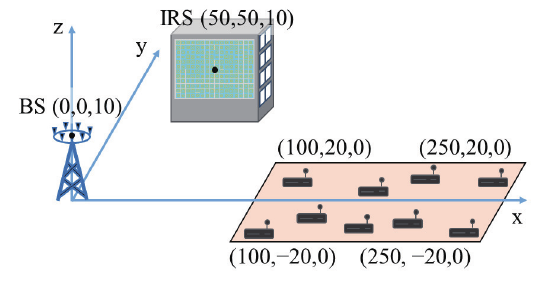
Figure 2. Simulation setup for the IRS-aided uplink